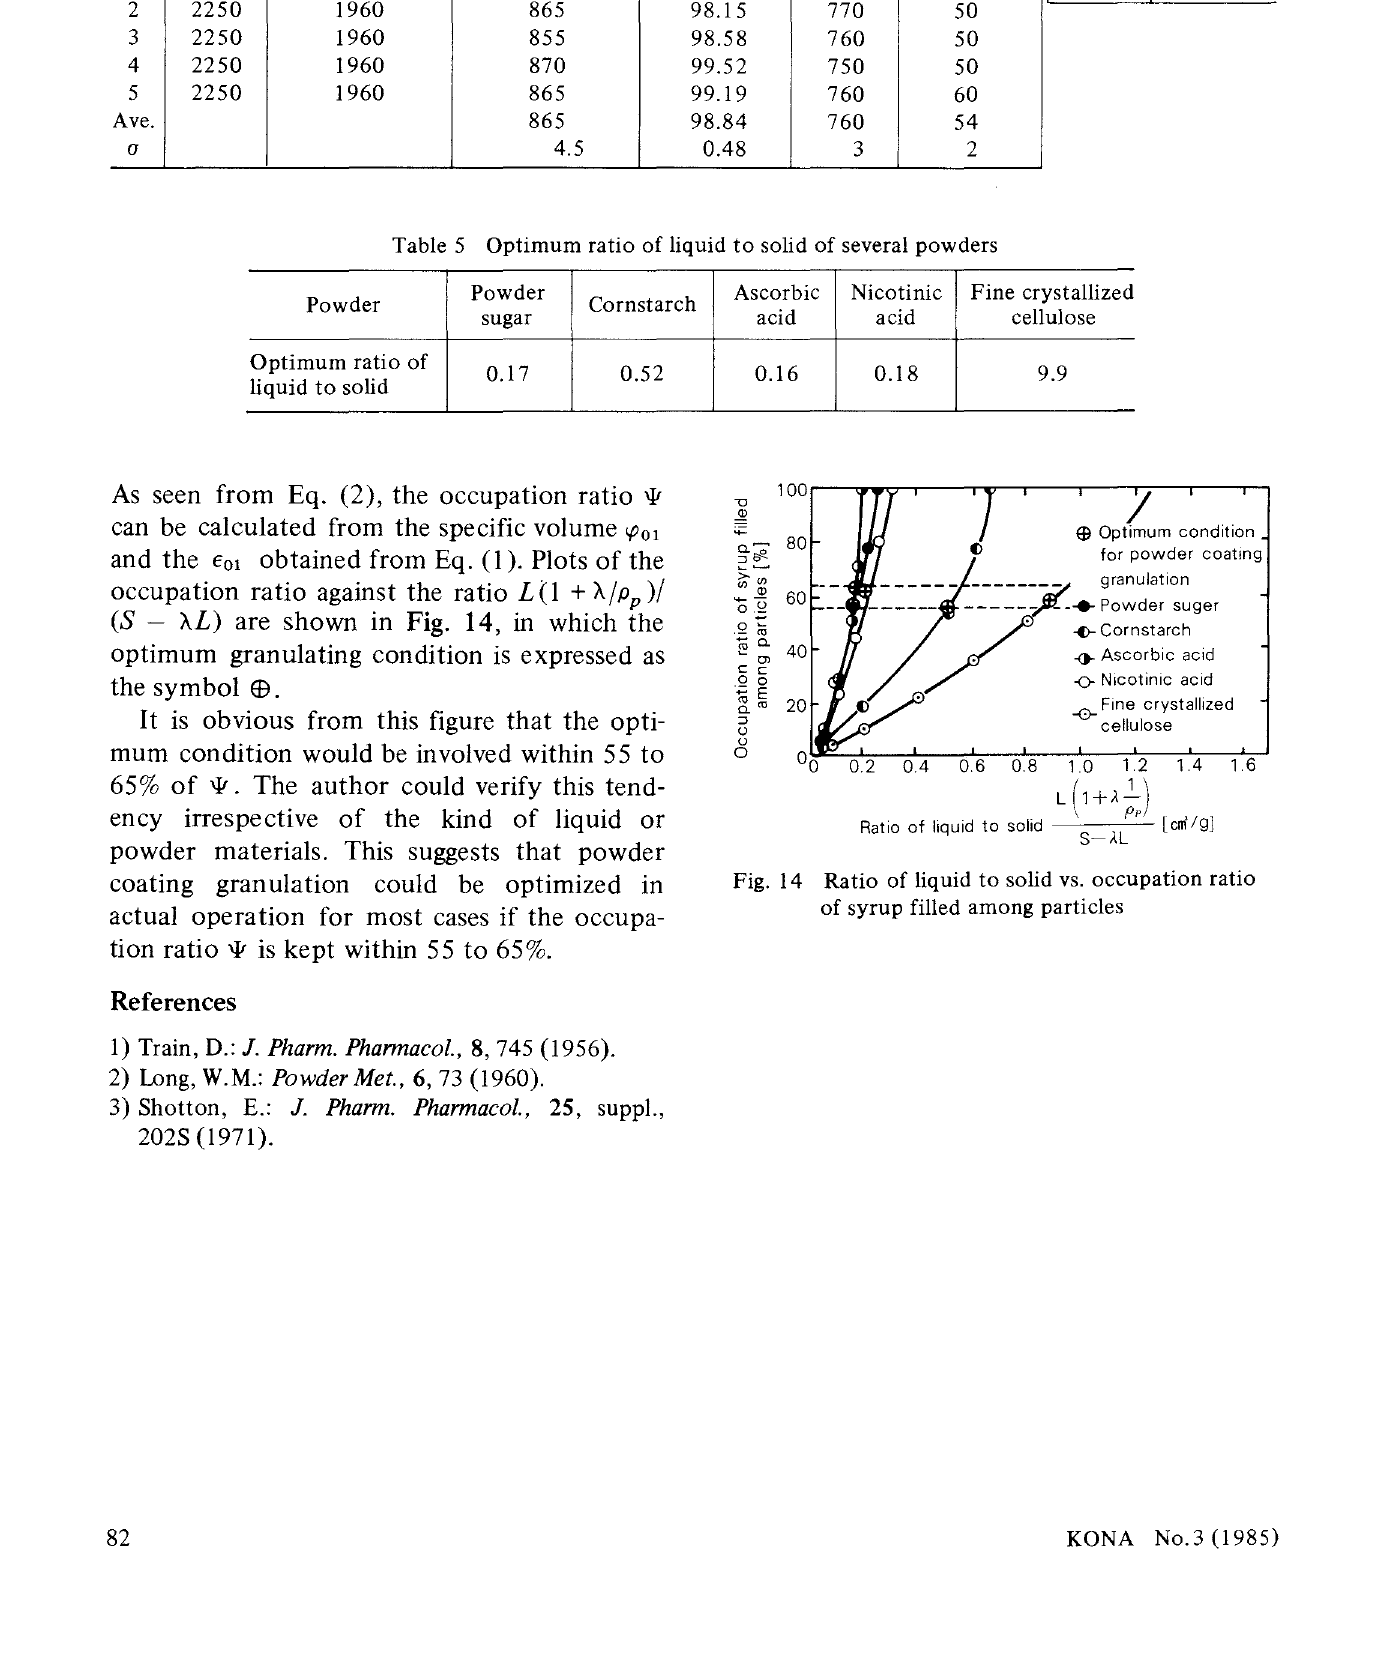
Table 5 Optimum ratio of liquid to solid of several powders